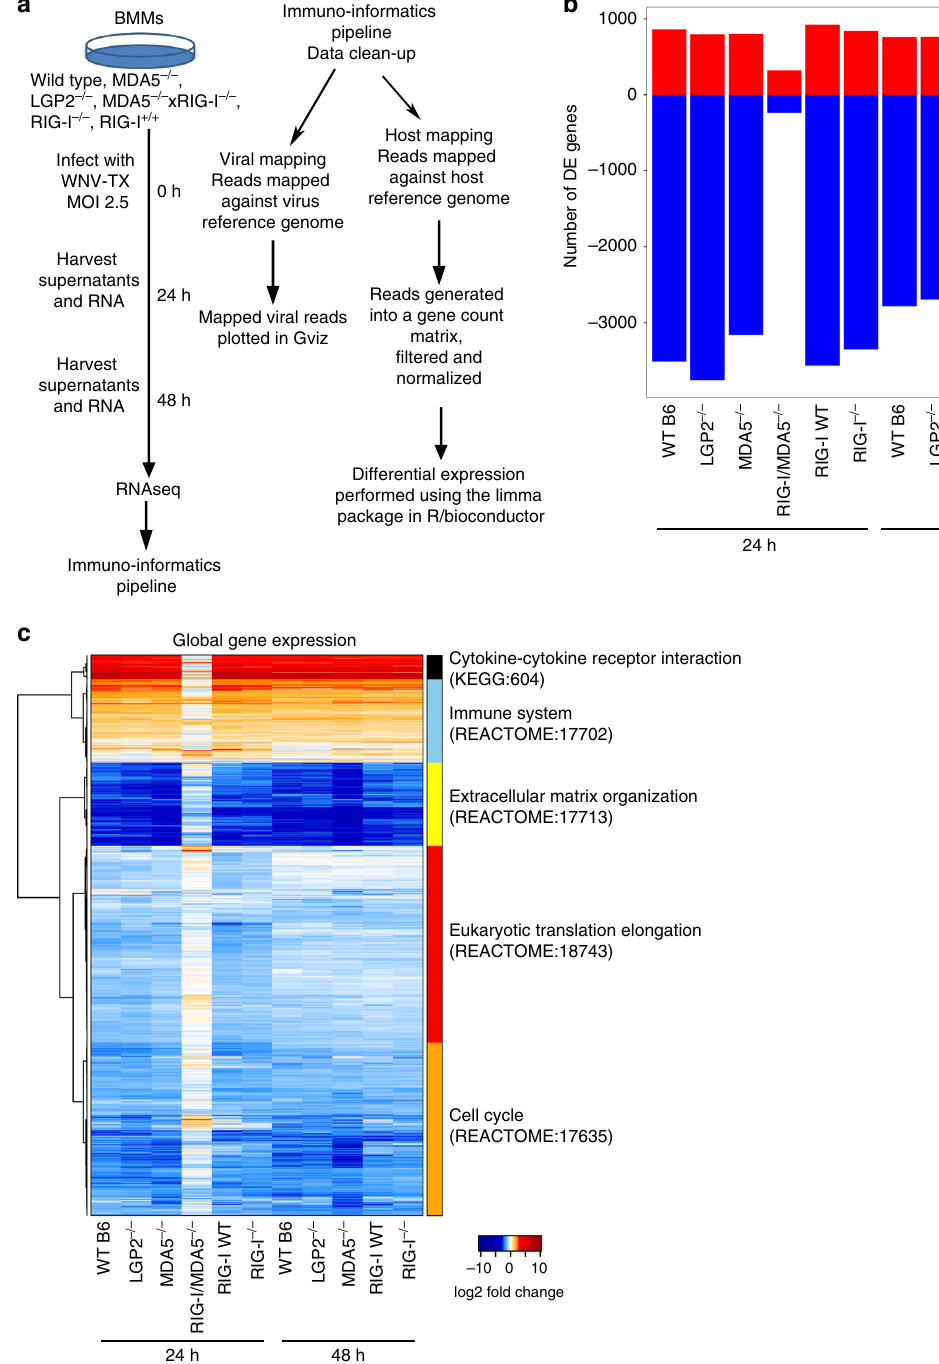
Fig. 2 RLRs dictate the transcriptome response to WNV infection. a Experimental design. BMMs were infected with WNV at MOI 2.5 for 24 or 48 h when RNA and supernatants were harvested for analysis. RNA was submitted to RNA sequencing and analyzed through an Immuno-informatics pipeline. Gene expression was determined by comparing the number of reads in the infected condition compared to that genotype ’ s mock condition. b Bar graph representing the total number of differentially expressed genes by genotype and time point. Induced genes are shown in red as positive numbers while suppressed genes are shown in blue as negative numbers. A single value is shown for each genotype and time point. c ) Heatmap of global gene expression. Genes signi fi cantly changed in the WT response compared to the WT mock are shown on the heatmap as horizontal rows. The columns are each genotype at the noted time points. Genes that had more mapped reads in the infected condition are shown in red while genes that had fewer mapped reads in the infected condition are shown in blue. On the right, genes with similar expression are grouped into blocks and assigned functional terms. n = 3 independent infections, RNA preparations, and sequencing results. Source data are provided as a Source Data fi